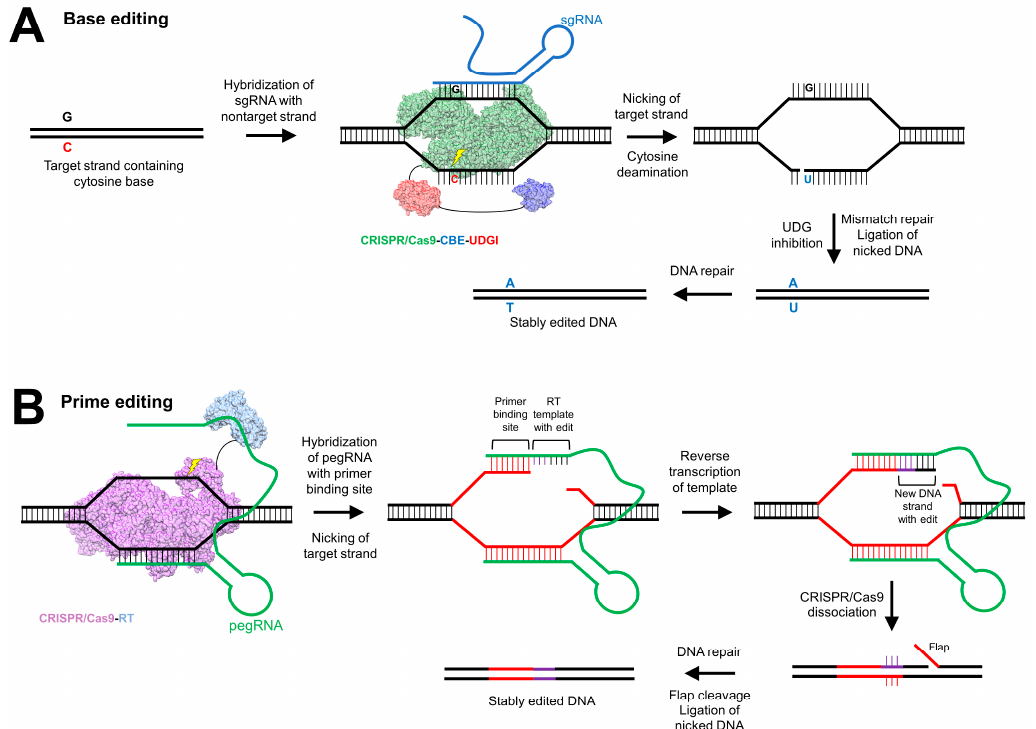
Figure 3. Base editing and prime editing use catalytically impaired Cas9 nuclease for single-strand nicking. ( A ) Base editing utilizes a catalytically impaired Cas9 nuclease (PDB ID: 5U0A) [165] fused with a cytosine base editor (CBE) (PDB ID: 1MQ0) [181] (or, alternatively, an adenine base editor), as well as a uracil DNA glycosylase inhibitor (UDGI) (PDB ID: 1UGH) [182]. The CRISPR / Cas9-CBE-UDGI also contains a single-guide RNA (sgRNA), which hybridizes with a target strand containing a cytosine–guanine base pair. The sgRNA binds to the nontarget strand containing the guanine base, and the Cas9 nuclease performs a single-stranded break (“nicking”) of the target strand on the 5 ′ end of the target cytosine base. The CBE domain catalyzes cytosine deamination to generate uracil on the target DNA strand, which is a substrate for the endogenous base excision repair (BER) mechanism. The UDGI domain suppresses BER, favoring mismatch repair to replace guanine on the nontarget strand with adenine. The nicked target strand is ligated, and through DNA repair, uracil on the target strand is replaced with thymidine, thus generating an adenine–thymidine base pair and stably edited DNA. ( B ) Prime editing uses a catalytically deficient Cas9 capable only of nicking (PDB ID: 5U0A) [165], fused to the Moloney murine leukemia virus reverse transcriptase (PDB ID: 1MML) [183], and bound to a prime editing guide RNA (pegRNA) that targets the region of interest in genomic DNA. After cleavage of the target strand, the pegRNA hybridizes with the primer binding site. Adjacent to this site on the pegRNA is the reverse transcriptase (RT) template with the gene editing template. The RT motif reverse transcribes the target strand using the pegRNA as a template. Once the pegRNA dissociates, the 3 ′ end with the reverse transcribed insertion binds to the nontarget DNA with a mismatch at the gene editing site. There is a flap at the 5 ′ end of the nicked strand that is cleaved off, and the nicked ends are subsequently ligated. The mismatched base pairs undergo DNA repair to generate stably edited DNA.